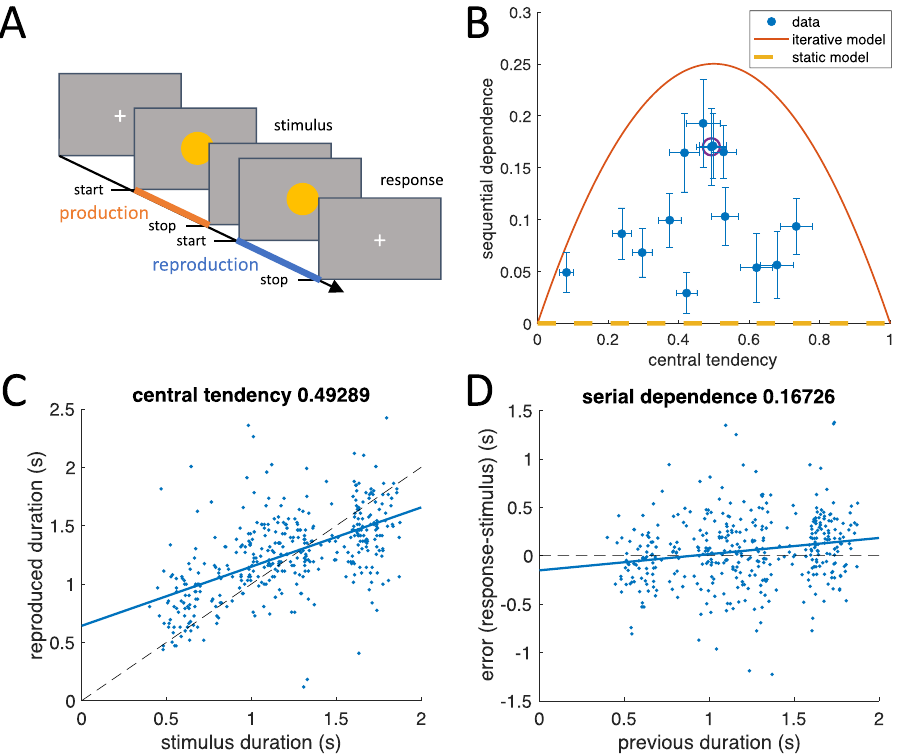
Figure 2. Central tendency and sequential dependence in a duration reproduction experiment. ( A ) Schematic procedure of a single trial. A visual cue is shown on a screen to indicate stimulus duration (production phase). Reproduction is performed by pressing a button (see also 16,17 , and “Materials and methods” for details). ( B ) Sequential dependence plotted over central tendency for all subjects (n = 14). Error bars denote standard error of the mean. The data point resulting for the single subject data presented in ( C ) and ( D ) is indicated by a purple circle. The orange parabola shows the predicted relation for the iterative model depicted in Fig. 1 (see SI Appendix A3: Serial dependence for an iterative Bayesian model). The yellow dashed line is the prediction of zero serial dependence for the static model in Fig. 1. ( C,D ) Raw data (blue dots) from one subject (400 trials). Stimuli were presented in random order. ( C ) Reproduced duration plotted over stimulus duration; the central tendency is shown by the regression line (blue). ( D ) Error (response-stimulus) in the current trial plotted over the stimulus duration of the previous trial. The sequential dependence is shown by the blue